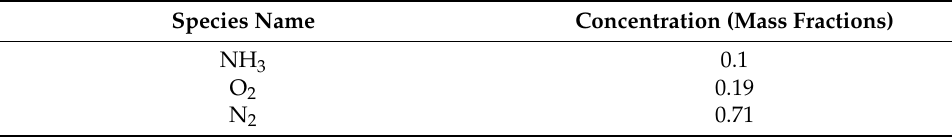
Table 1. The composition of the continuous phase (gas mixture) at the